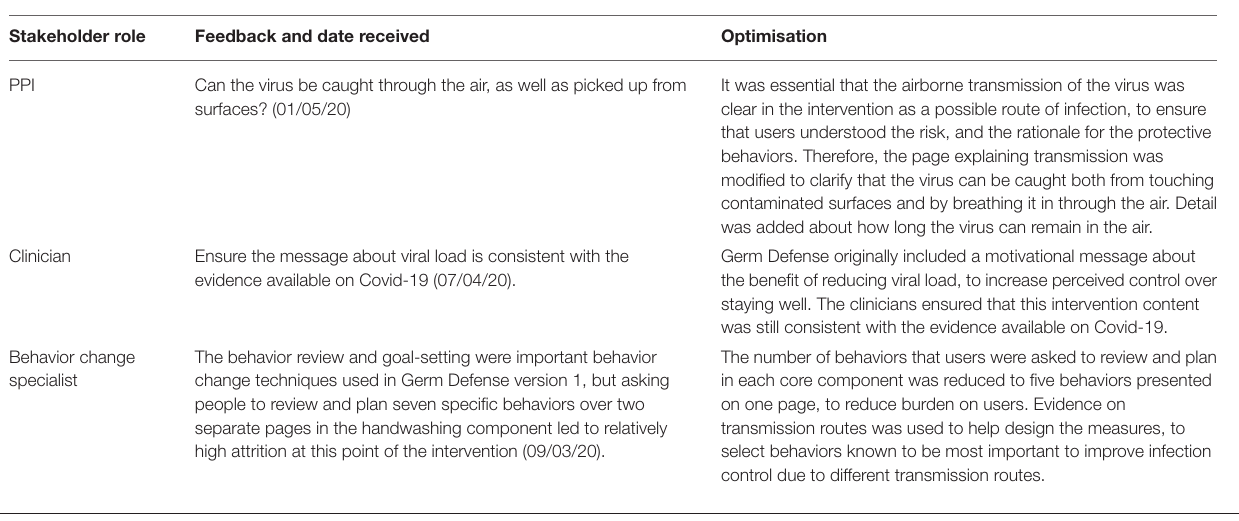
TABLE 1 | Examples of how stakeholder feedback informed intervention